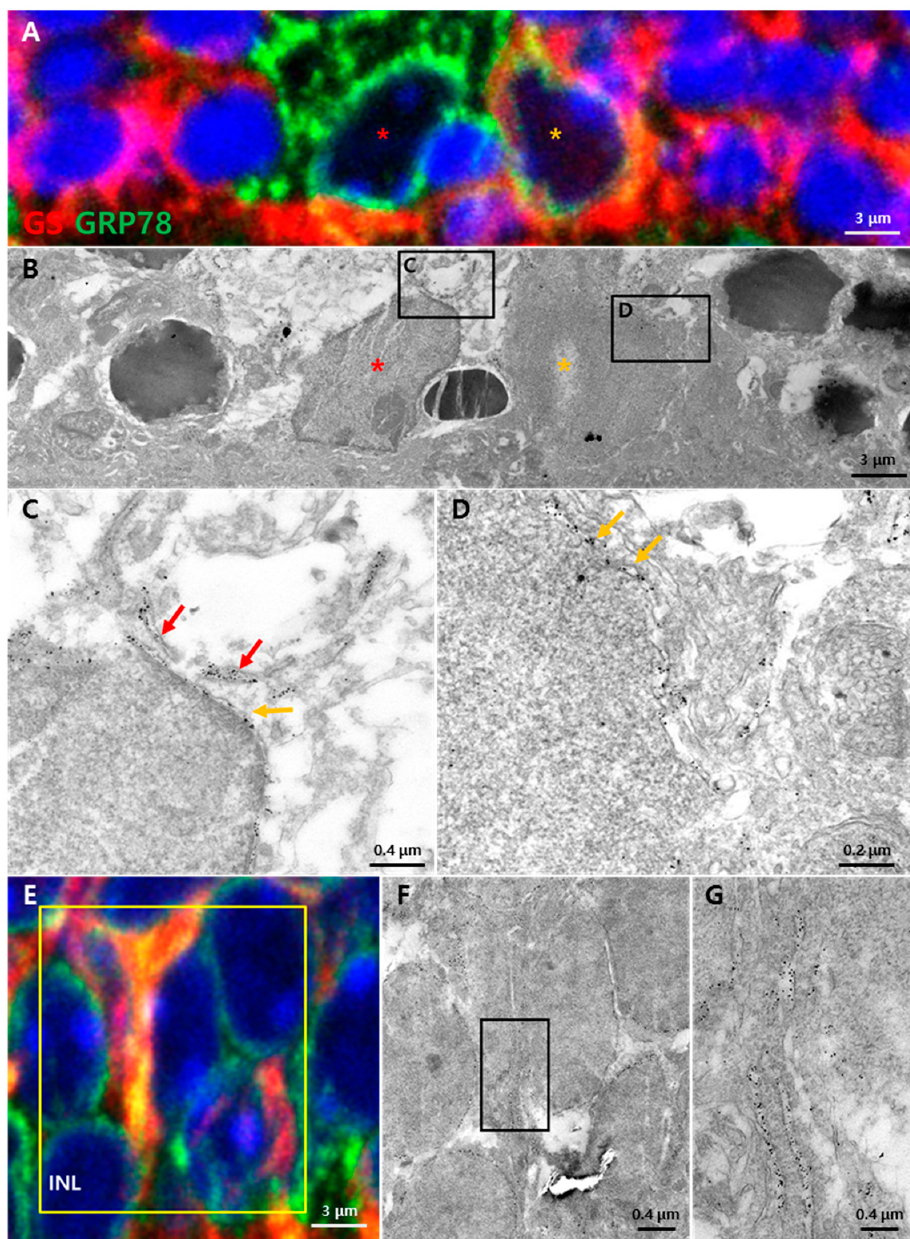
Figure 4. Subcellular GRP78 localization in the injured retina 72 h after light exposure. Semi-thin sections of the retina stained by GRP78 (green, gold), GS (red) and DAPI (blue). ( A ) Microglia and migrated Müller glia in the ONL. Microglia (red asterisk) were more strongly labeled by GRP78 than Müller glia without GS while Müller glia (orange asterisk) were labeled by both GRP78 and GS. ( B ) EM images of microglia (red asterisk) and migrated Müller glia (orange asterisk) in the same region as (A). ( C ) Immuno-gold-labeled GRP78 was detected in the perinuclear space (orange arrow) and lumen of the ER structure (red arrows) of the microglia. ( D ) Immuno-gold-labeled GRP78 was detected in the perinuclear space of the Müller glial cell (orange arrows). ( E ) Confocal images in the INL of an injured retina with Müller glia processes. ( F ) EM images matched with the yellow box in (E). Processes of the Müller glia in the INL labeled by GRP78. ( G ) A higher magnification of the Müller glia process in (F). Membranous structures containing immuno-gold-labeled GRP78 located in Müller glia processes.